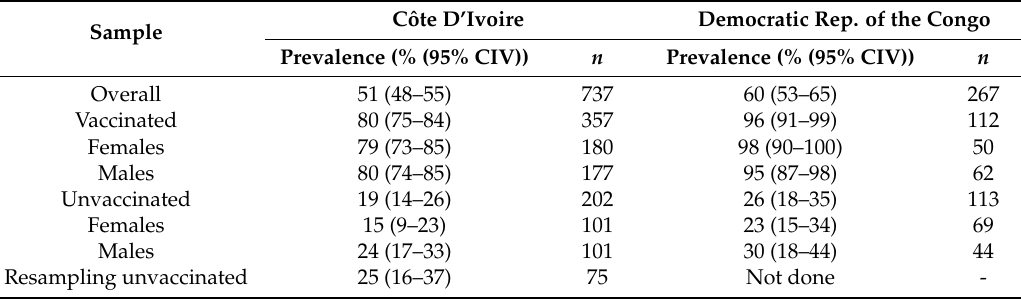
Table 1. Anti-OPV seroprevalence in participants living in CIV and COD.